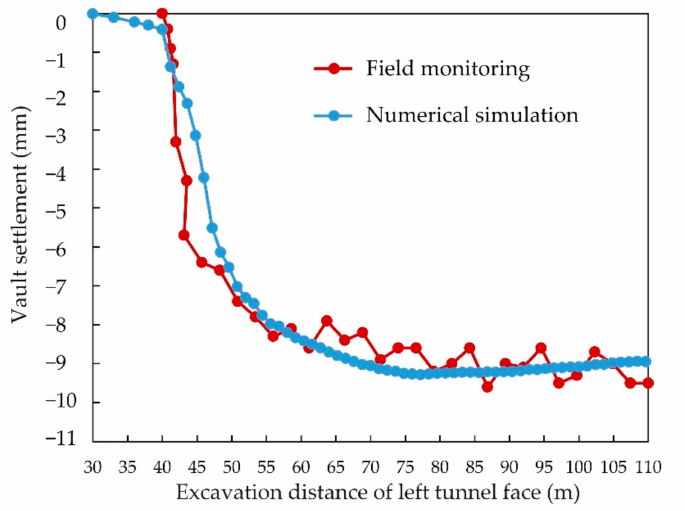
Figure 5. Vertical settlement of left tunnel vault at 40 m away from the